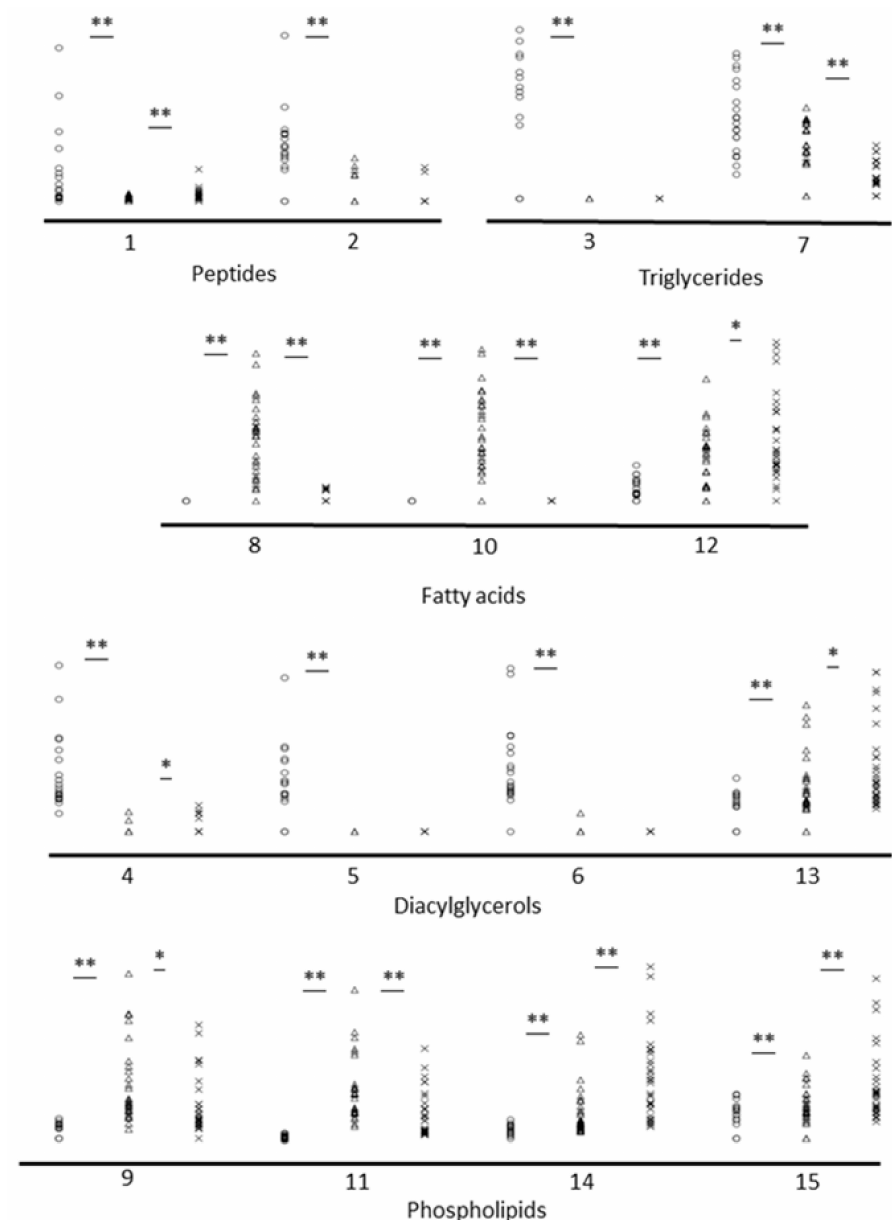
Figure 3. Results of the univariate statistical analysis, showing putative metabolites with statistically significant differences among groups—negligible ( Esox Lucius and Acipenser ruthenus ) ( × ), gradual ( Sander lucioperca and Perca fluviatilis ) ( ∆ ) and rapid ( Oncorhynchus keta and Oncorhynchus gorbuscha ) ( ageing fishes. Scatter plots show the relative intensity comparison of three groups in each significantly different metabolite (* p < 0.05; ** p < 0.01 calculated from the nonparametric Mann–Whitney U test). The data represent the putative metabolites numbers corresponding to Table